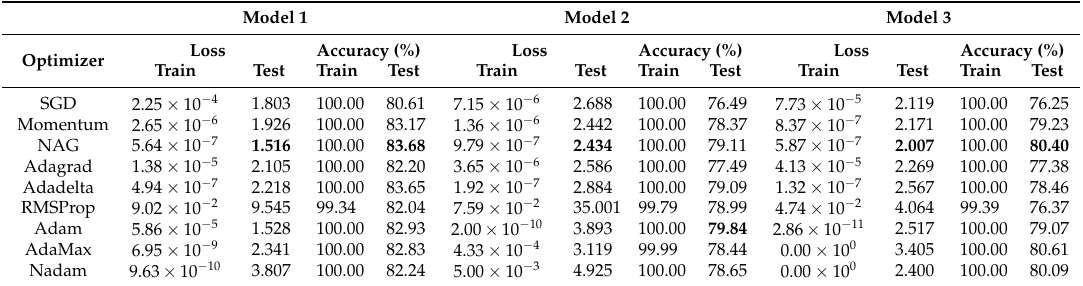
Table 2. Performance of baseline models trained with different optimizers on CIFAR-10 dataset.